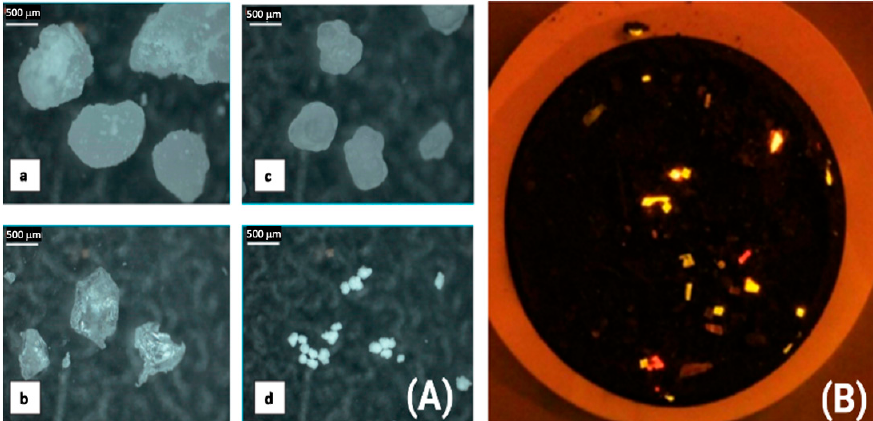
Figure 2 . ( A ) Optical microscope images of microplastic particles: ( a ) Polyethylene (PE) particle; ( b ) polyethylene terephthalate (PET) particle; ( c ) polypropylene (PP) particle; ( d ) polyvinyl chloride (PVC) particle. ( B ) Microplastics of six different polymer types, dyed with Nile Red (1000 μ g·mL − 1 for 30 min). Figures reproduced from Abbasi et al. [38] and Maes et al. [46] with permission of pub- lishers.